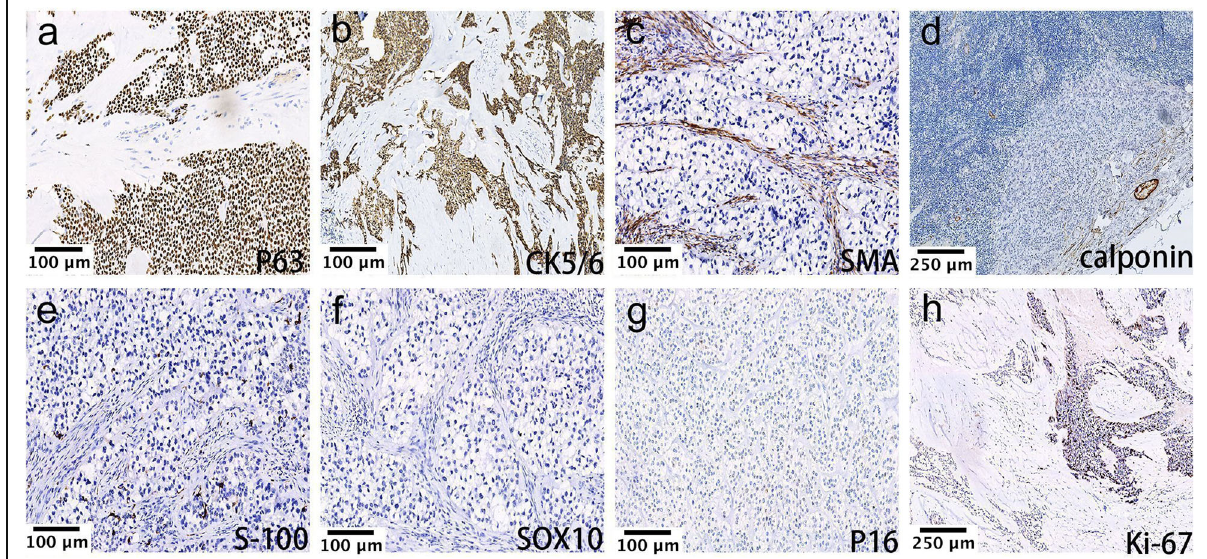
Fig. 5 IHC for the CCC. The tumor cells were positive for ( a ) p63 (Case 1, IHC × 200) and ( b ) CK5/6 (Case 1, IHC × 200), and negative for ( c ) SMA (Case 2, IHC × 200), ( d ) calponin (Case 3, IHC × 100), ( e ) S-100 protein (Case 2, IHC × 200), and ( f ) SOX10 (Case 2, IHC × 200). ( g ) p16 expression was negative (Case 3, IHC × 200). ( h ) Different Ki-67 immunoreactivity was noted between the conventional region in the lower left corner (median, 1.9%) and the HGT region in the upper right corner (median, 42.5%) (Case 1, IHC ×